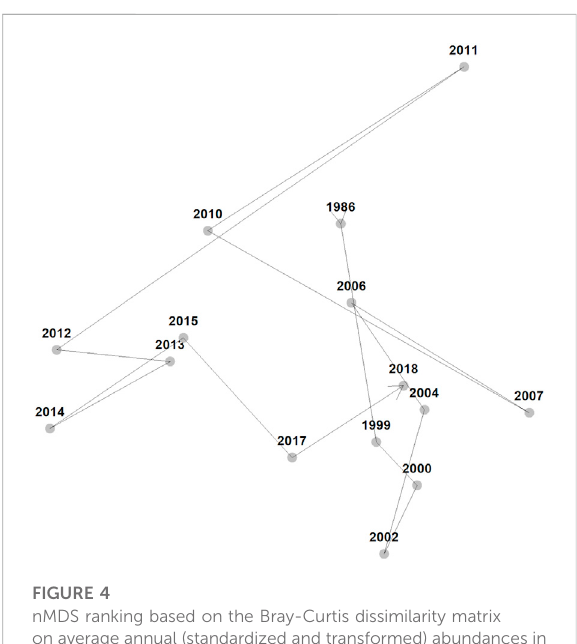
FIGURE 4 nMDS ranking based on the Bray-Curtis dissimilarity matrix on average annual (standardized and transformed) abundances in the Andalién River basin. The trajectory of the fi sh assemblage structure is shown for 1986 – 2018. Stress value